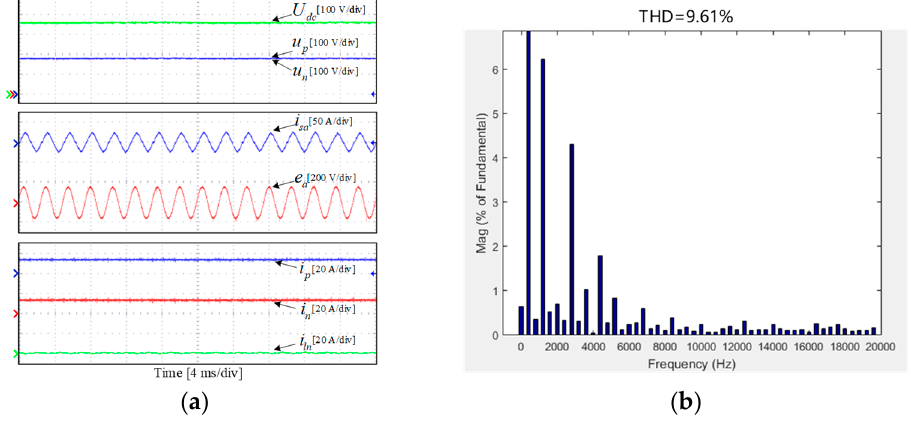
Figure 13. Experimental results based on the traditional 12-sector division. ( a ) Voltage and current waveforms of TCIBAR and ( b ) fast Fourier transform (FFT) results of the phase current.